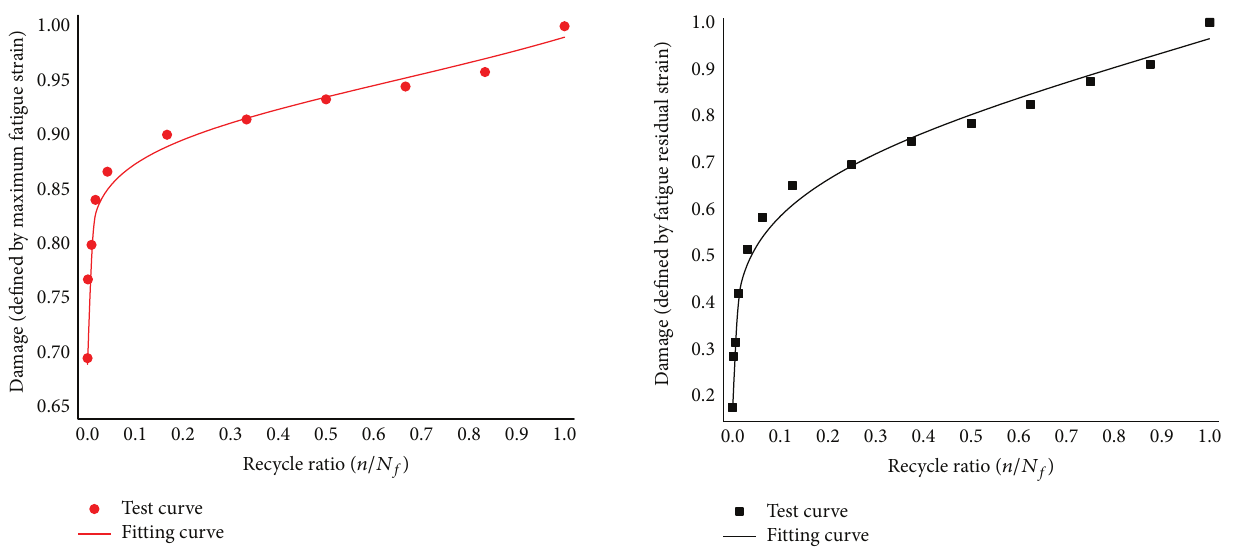
Figure 9: Damage result of JL-2 based on fatigue residual strain.